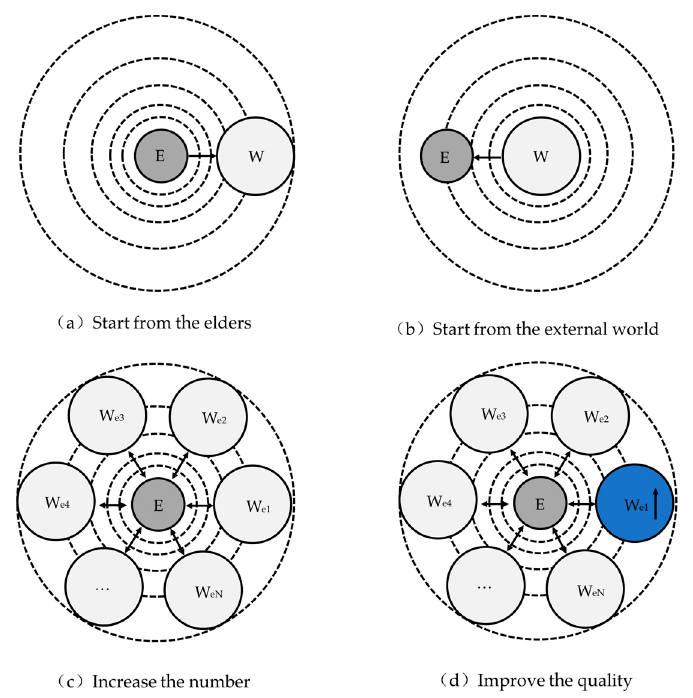
Figure 8. The four principals of building connectivity for the elderly. Note: *E = The elders; W = The external world; We1-N = The external world element.